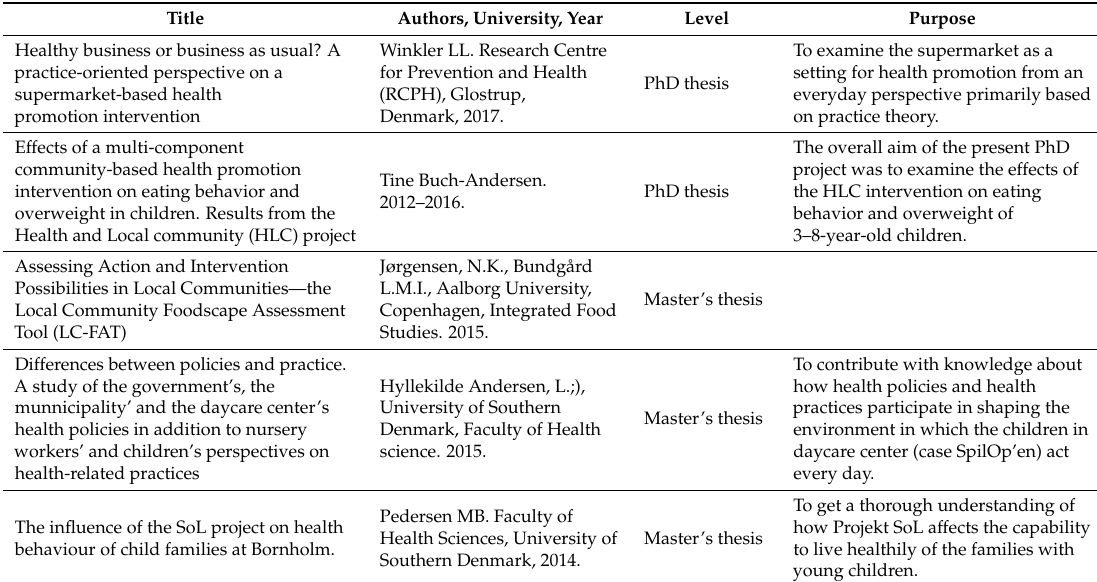
Table A1. List of other associated SoL research projects not mentioned in the main